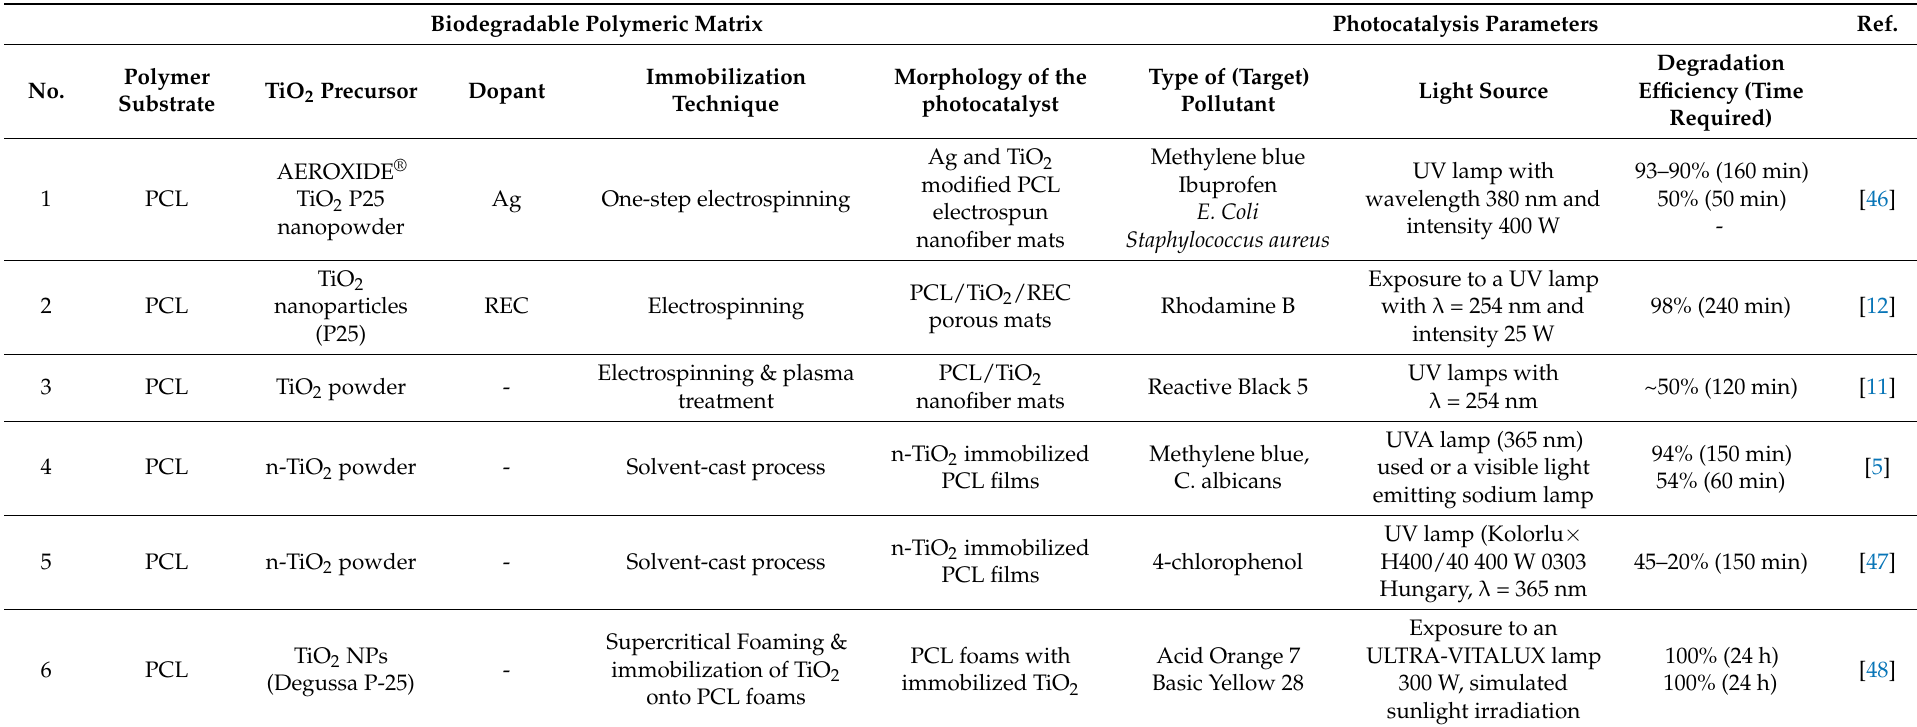
Table 5. Summary of the PCL-supported TiO 2 photocatalysts enclosed in the presented